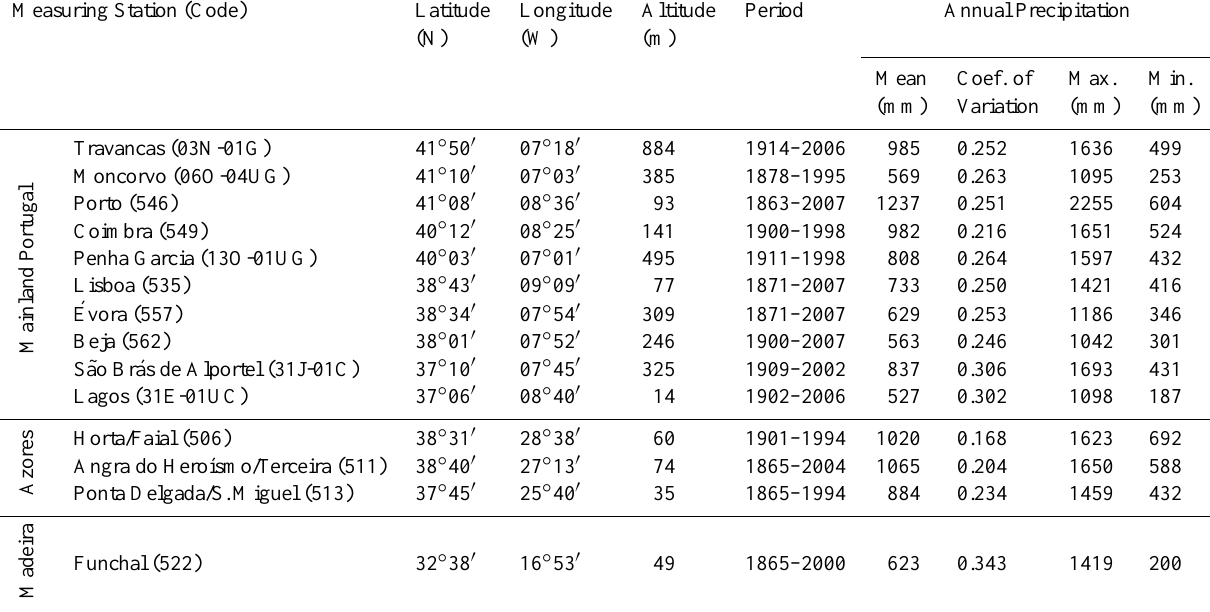
Table 1. Identification of the precipitation measuring sites and some descriptive statistics for the annual time series. Measuring Station